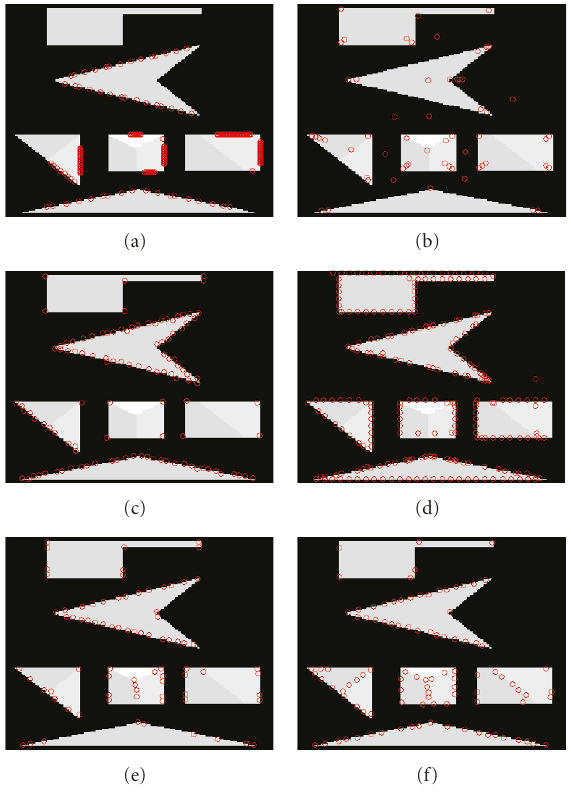
Figure 5: Feature points detected in the synthetic image by (a) Harris method (b) Lowe’s method, (c) Tomasi’s method, (d) Loupias’s technique, (e) Yeh’s algorithm, and (f) proposed technique.